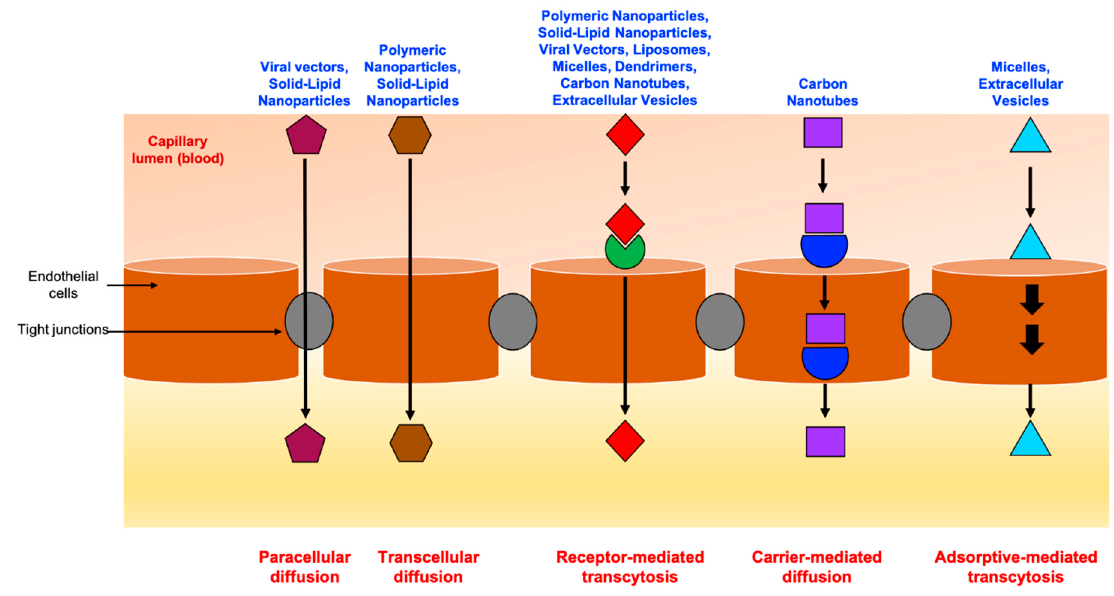
Figure 2. Transport routes across the BBB.